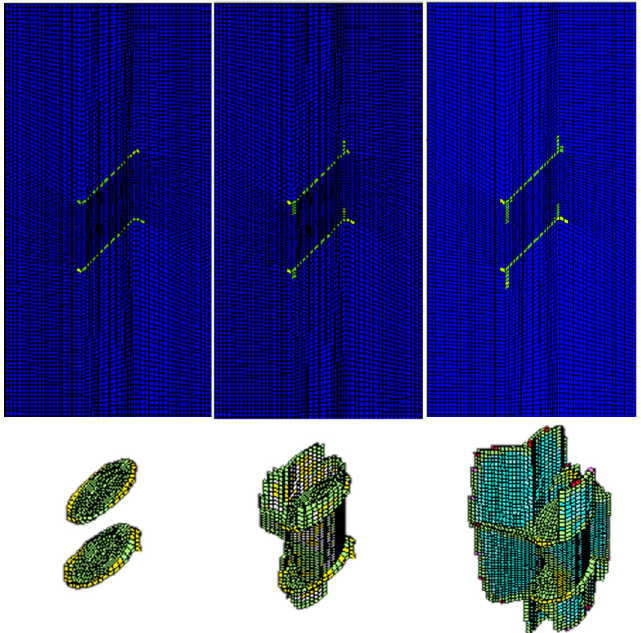
Figure 11. Fissure development and profiles of secondary cracks under fissure water pressure (7%  α ).